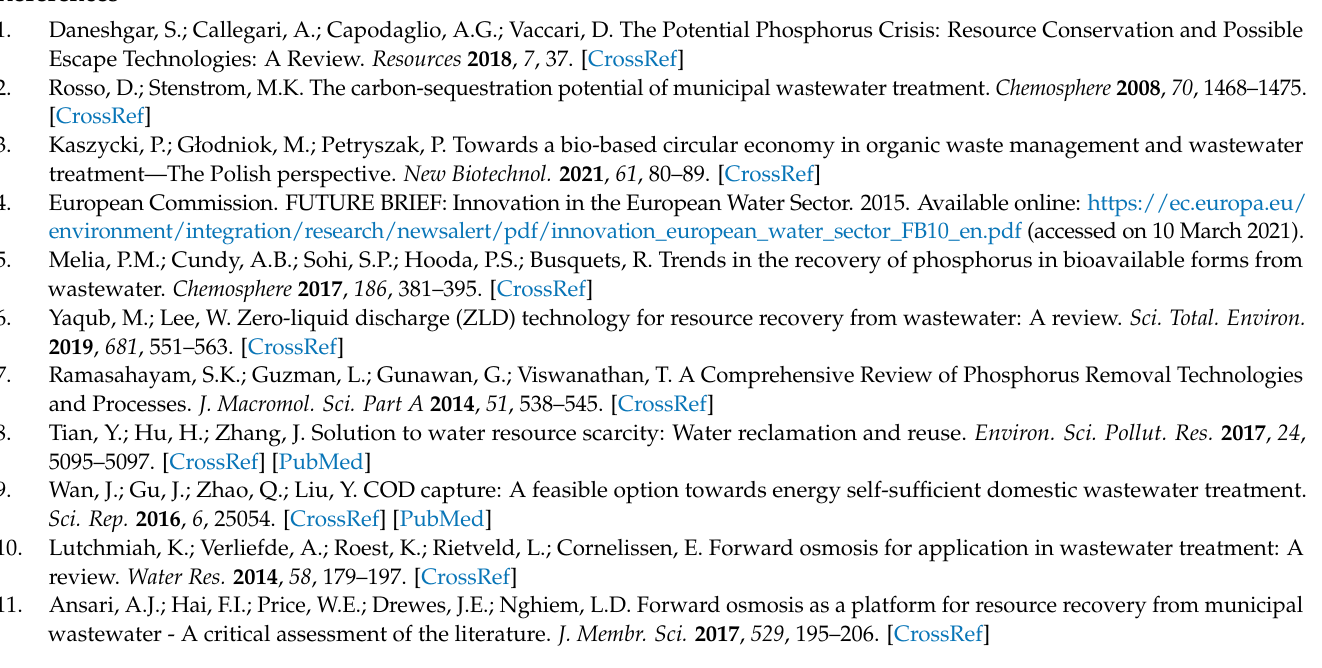
Figure S3. SEM images of fouled membranes from selected FO experiments. (a) Backscatter image at 45 × magnification of membrane sample from Exp. LL-3; (b); Backscatter image at 200 × magnification of membrane sample from Exp. HL-6** (c) Backscatter image at 200 × magnification of